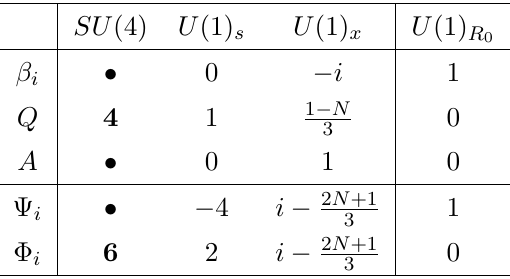
Table 4 . Transformation rules of the matter fields of theory T A under the global